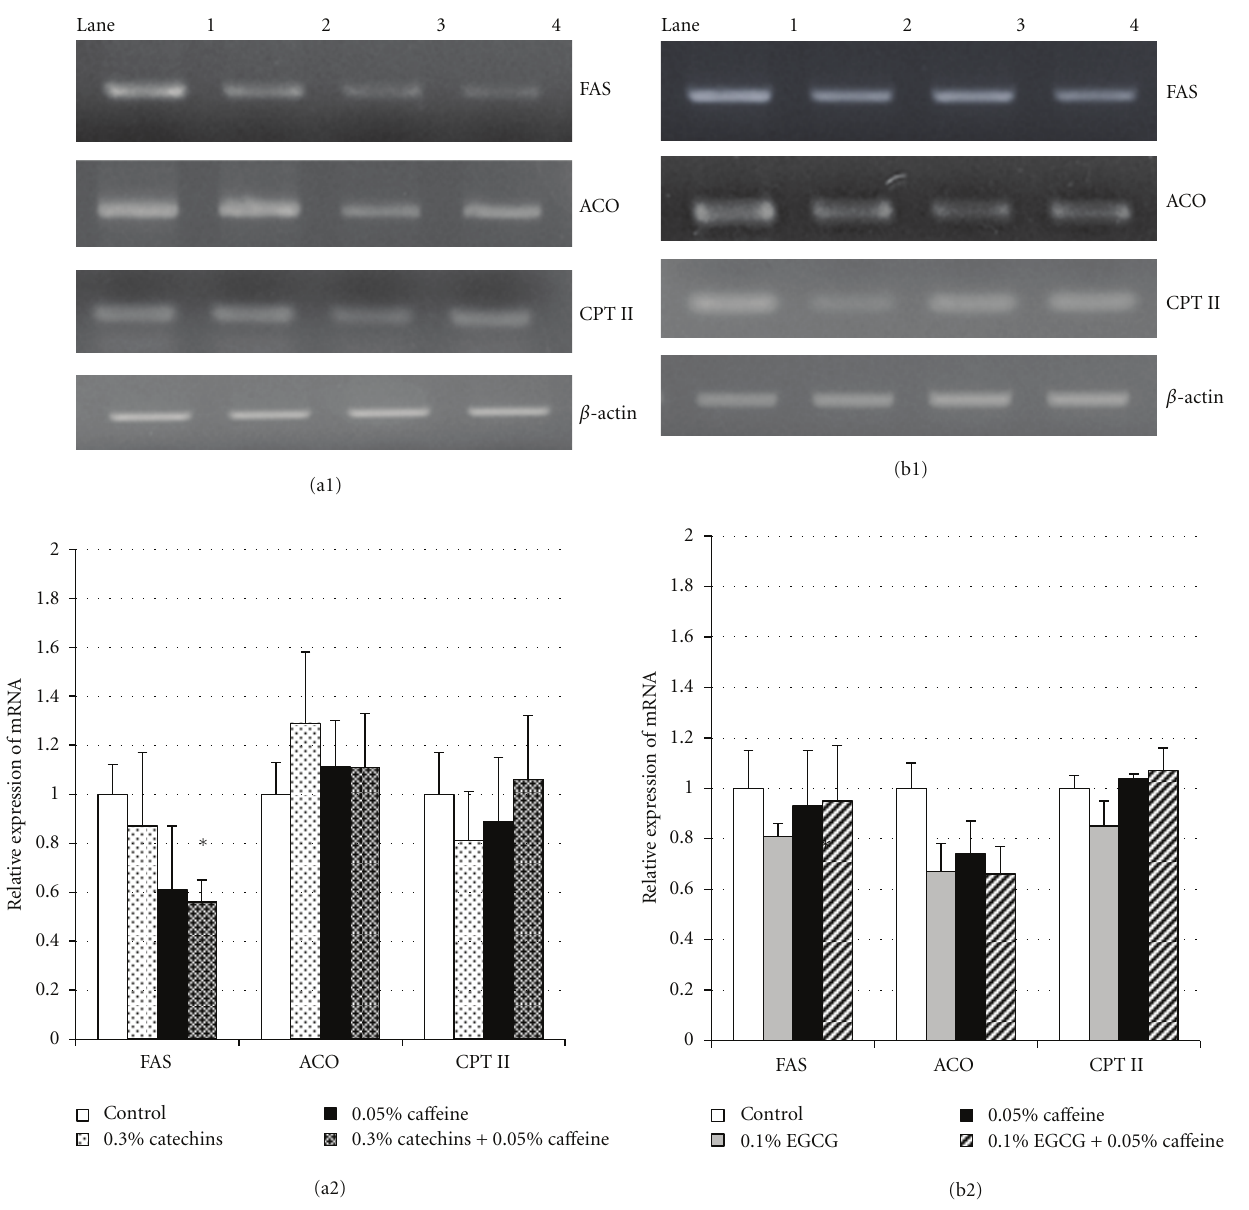
Figure 4: E ff ects of catechins, EGCG, and ca ff eine on the mRNA expression of FAS, ACO, and CPT II in liver in mice. (a1) Fluorescence intensity of mRNA of FAS, ACO, and CPT II by RT-PCR analysis in liver in mice fed the diets containing 0.3% catechins, 0.05% ca ff eine, 0.3% catechins + 0.05% ca ff eine for 4 weeks. Lane 1: control, lane 2: 0.3% catechins, lane 3: 0.05% ca ff eine, lane 4: 0.3% catechins + 0.05% ca ff eine. (b1) Fluorescence intensity of mRNA of FAS, ACO, and CPT II by RT-PCR analysis in liver in mice fed the diets containing 0.1% EGCG, 0.05% ca ff eine, 0.1% EGCG + 0.05% ca ff eine for 4 weeks. Lane 1: control, lane 2: 0.1% EGCG, lane 3: 0.05% ca ff eine, lane 4: 0.1% EGCG + 0.05% ca ff eine. (a2 and b2) Expression levels of mRNA of FAS, ACO, and CPT II determined by RT-PCR analysis in liver in mice fed the diets containing catechins and ca ff eine (a2) and EGCG and ca ff eine (b2) for 4 weeks. The level was determined from the fluorescence intensity by a image analysis system and showed as a relative value to the control. Results are given as mean ± SE of 8 mice in each groups. ∗ Significant di ff erence compared with the control ( P < 0 .